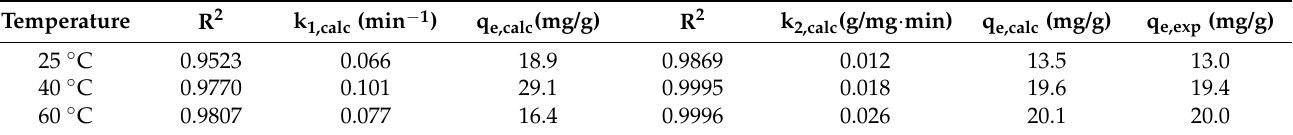
Figure 12. The fittings of adsorption kinetics: ( a ) linear pseudo-first-order model, ( b ) linear pseudo- second-order model, ( c ) Elovich model. Table 3. Calculated kinetic parameters and correlation coefficients for the different temperatures